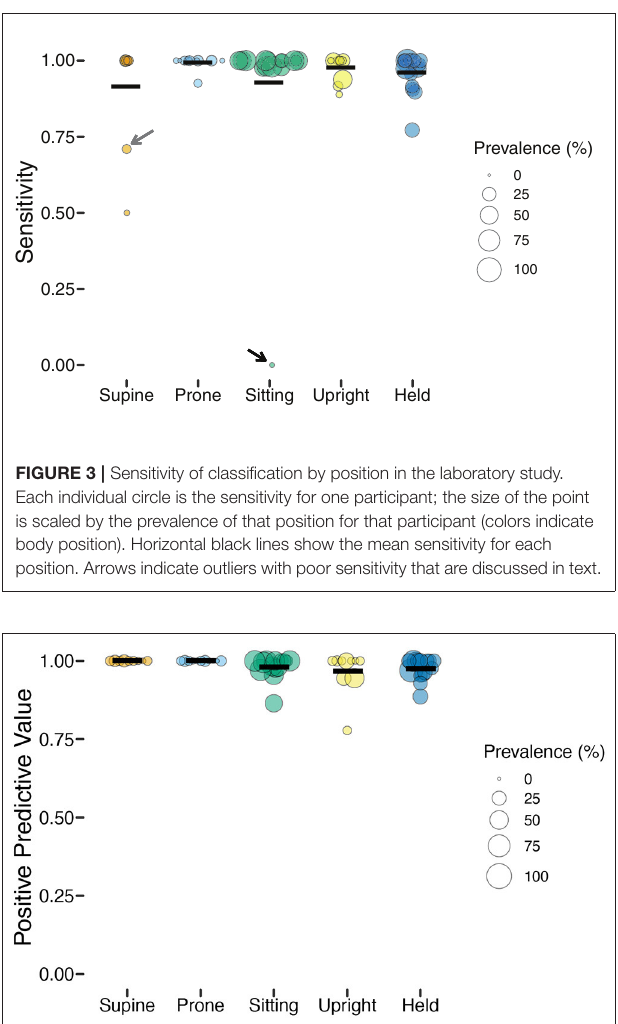
FIGURE 4 | Positive predictive value (PPV) of classification by position in the laboratory study. Each individual circle is the PPV for one participant; the size of the point is scaled by the prevalence of that position for that participant (colors indicate body position). Horizontal black lines show the mean PPV for each position.